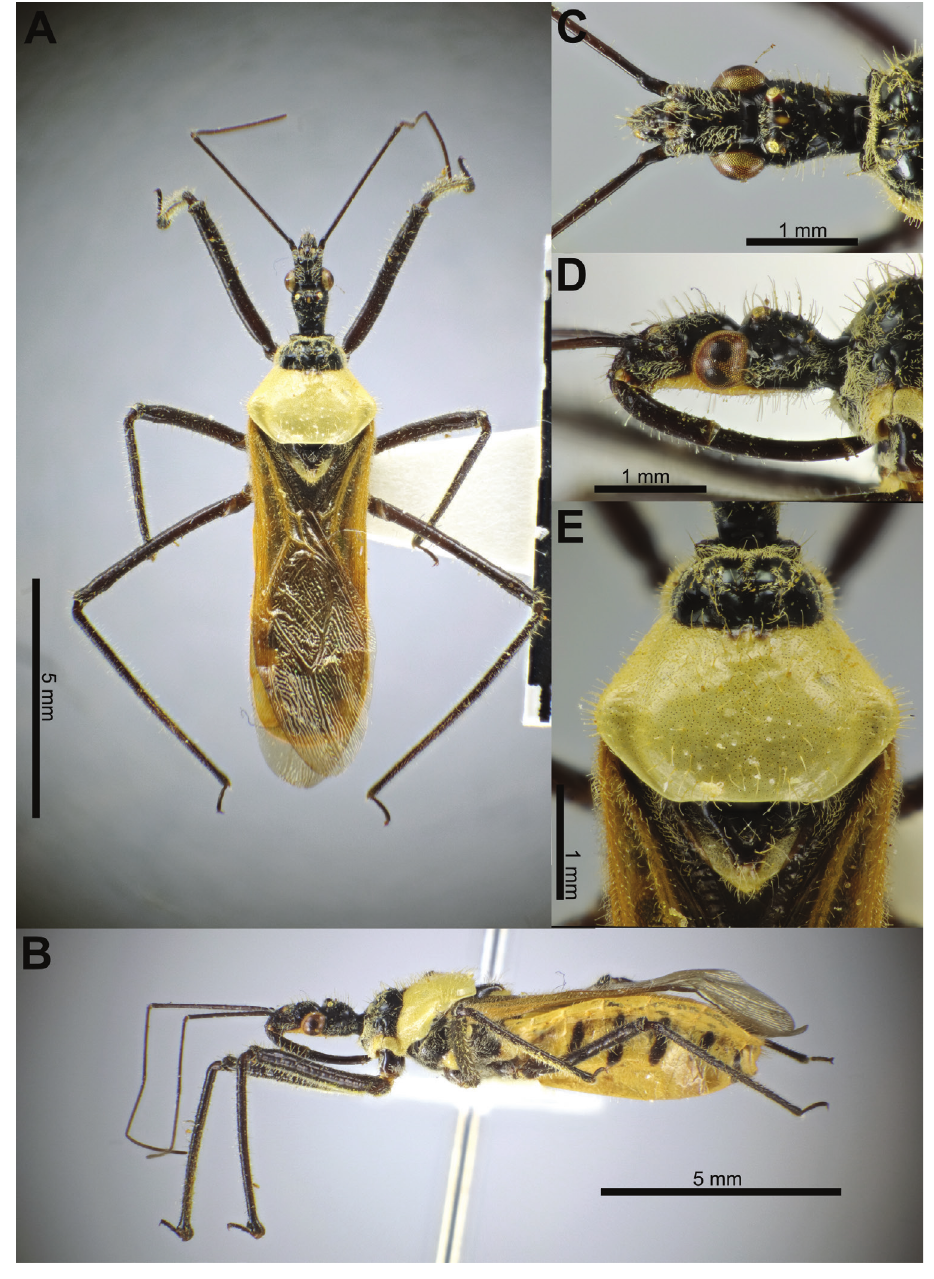
Figure 9. Biasticus flavus (Distant, 1903), ♀ , LA-Redu-2004-006 A body in dorsal view B body in lat- eral view C head in dorsal view D head in lateral view E pronotum in dorsal